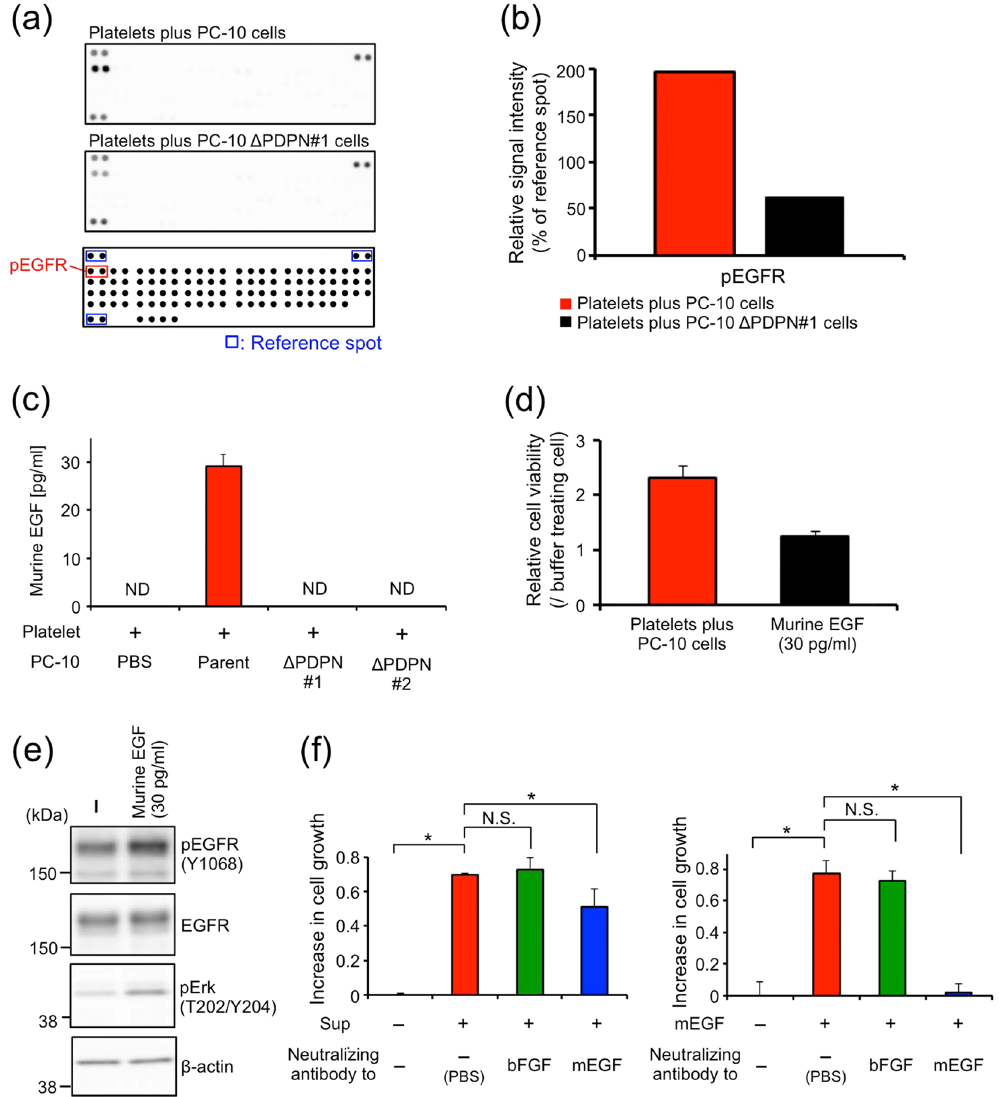
Figure 3. Platelet-derived murine epidermal growth factor (EGF) partially contributed to cell growth promoted by platelet releasates during PMPA. ( a , b ) PC-10 (parent) cells starved for 24 hours were treated with supernatants collected from platelets incubated with PC-10 (parent) or PC-10 Δ PDPN#1 cells. The treated cell lysates were used in a phospho-RTK array according to the manufacturer’s protocols. The probed membranes are shown in ( a ). The signal intensity of epidermal growth factor receptor (EGFR) phosphorylation (within red squares) was quantified by Image J software (NIH). The signal intensities of six reference spots (within blue squares) in each membrane were measured and defined as 100%. The relative intensities of duplicate spots are shown in ( b ). ( c ) Murine EGF concentration in the supernatants collected from platelets incubated with PBS, PC-10 (parent), PC-10 Δ PDPN#1 and PC-10 Δ PDPN#2 cells was measured by ELISA. ND; Not detected. All data are shown as means ± SD of triplicate experiments. ( d ) PC-10/ZsG cells were incubated with supernatant of a PC-10 (parent)-platelet reactant or 30 pg/ml murine EGF under 0.5% FBS condition. After 72 hours incubation, the cell viability of the PC-10/ZsG was calculated from ZsGreen fluorescence. All data are shown as means ± SD of triplicate experiments. ( e ) PC-10 (parent) cells starved for 24 hours were treated with 30 pg/ ml murine EGF for 2.5 minutes. After ice-cold PBS wash, the cells were lysed with SDS lysis buffer, and Western blot analysis was performed. ( f ) The supernatant of a PC-10 (parent)-platelet reactant (left) or 5 ng/ml murine EGF (right) was incubated with 28.6 μ g/ml anti-human bFGF or anti-mouse EGF neutralizing antibody (R&D Systems) for 1 hour in a 37 °C water bath. Then, the mixture was added to PC-10/ZsG cells. After 72 hours of cultivation under 0.5% FBS condition, the cell viability of the PC-10/ZsG was calculated from the ZsGreen fluorescence. All data are shown as means ± SD of triplicate experiments. * P < 0.05 by Mann–Whitney U -test. N.S.: Not